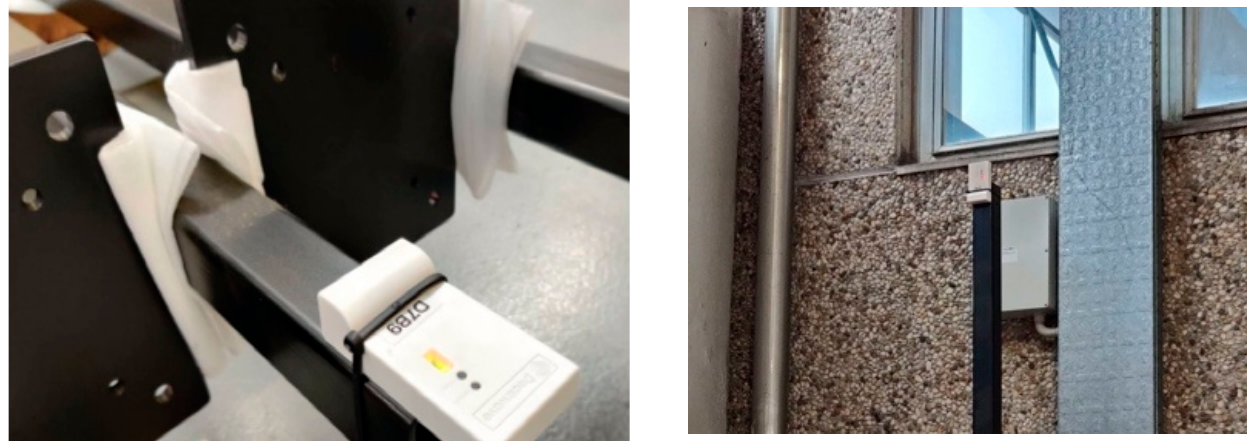
Figure 15. Anchor devices fixed on the edge of the pole.